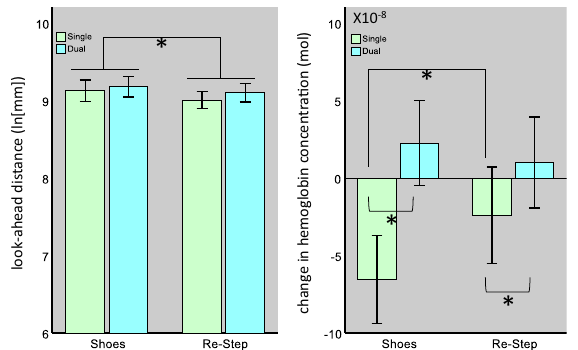
Figure 3. The effects of the shoe type and task type on gaze distance (left) and on PFC activity (right). For gaze distance, we found a significant main effect for the shoe type. For PFC activity, we found a significant main effect for the task type and a significant interaction term, indicating that, for both shoe types, values increased from the single- to the dual-task condition, but the difference between shoe types was significant only during single-task walking. [*] indicates a significant effect. Bars represent mean values, and error bars the 95% CI of the mean.